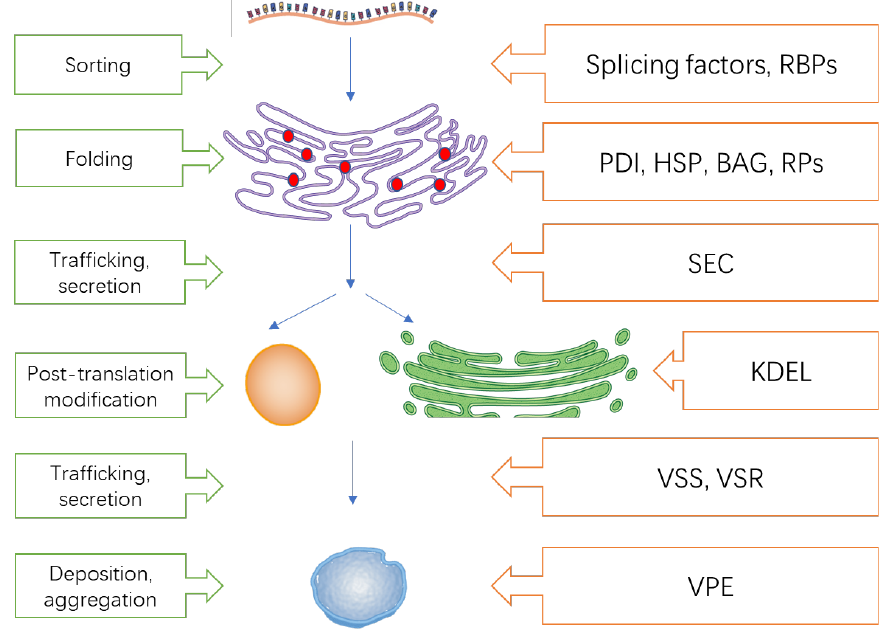
Figure 4. Important genes and proteins participated in the deposition of SSPs.